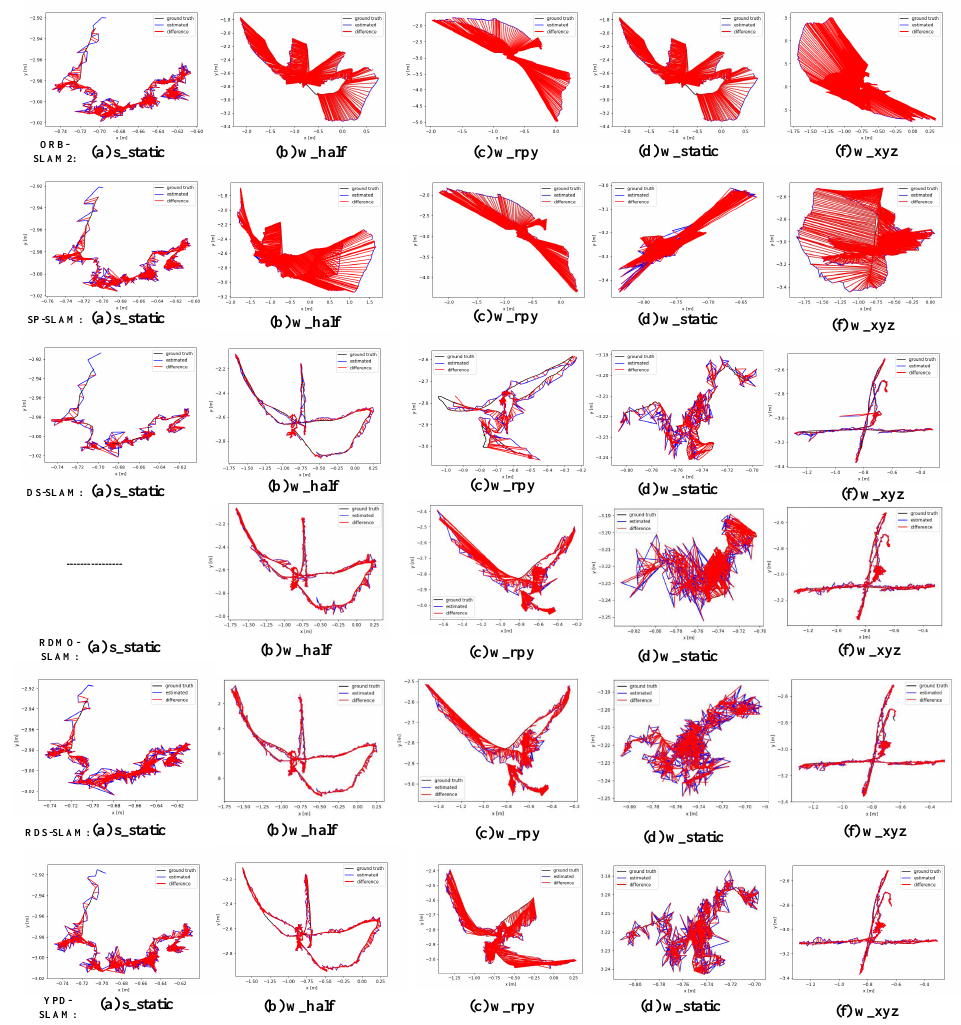
Figure 9. Error plot for ATE. Black represents the groundtruth, blue represents the estimated trajectory, and red represents the gap between the estimated trajectory and the real trajectory.